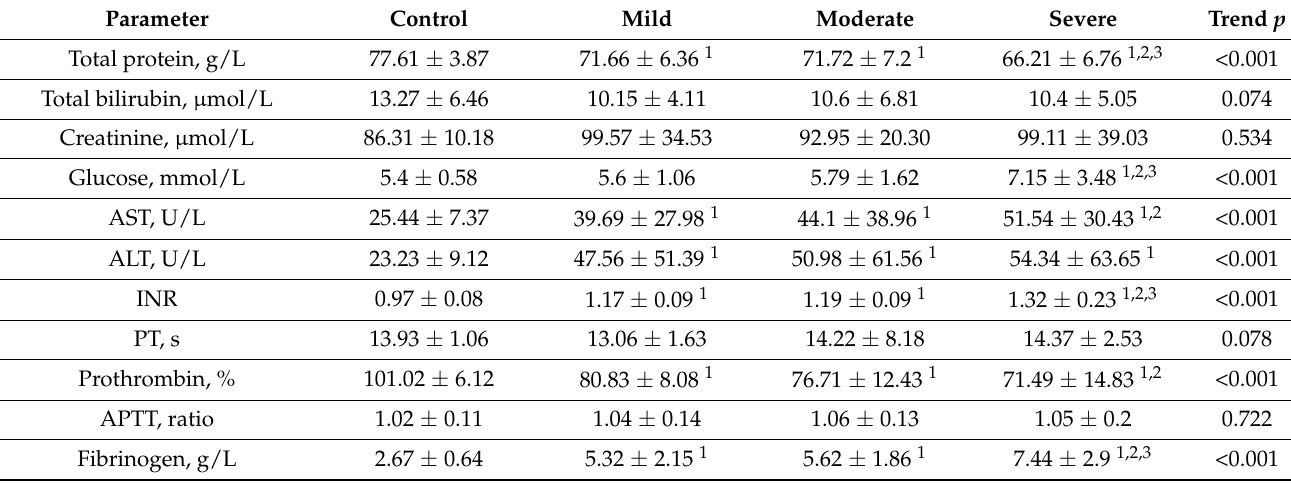
Table 2. Biochemical and hemostatic variables in patients with different COVID-19 severity in comparison to healthy controls.